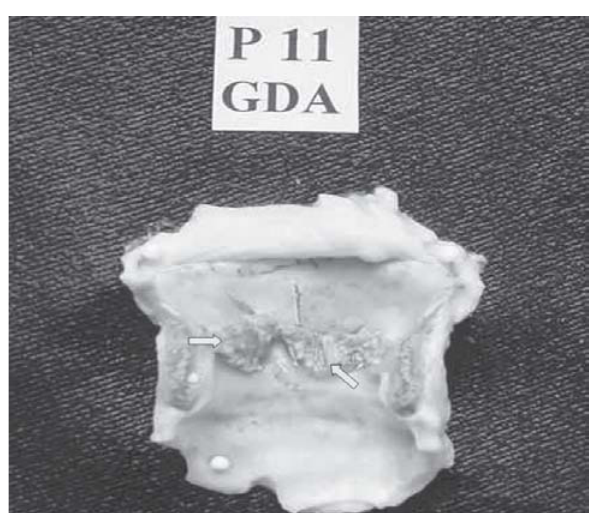
Fig. 4 - Heteroenxerto valvar pulmonar porcino em GDA, após